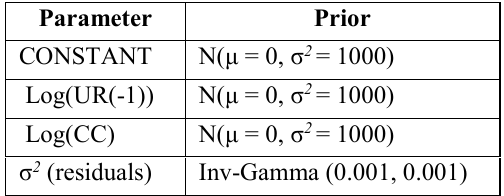
Table 2. Parameter Priors